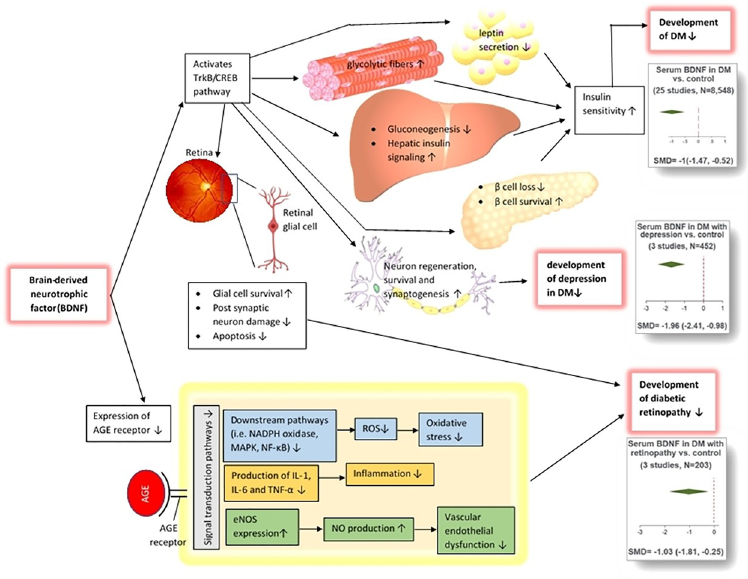
Fig 19. Summary of the pathophysiology and meta-analysis of the association between BDNF and DM. The image of the retina was copyright free and taken from the following link: https://www.kindpng.com/imgv/ThRohi_eye- structure-without-label-hd-png-download/. The image of the liver was copyright free and taken from the following link: https://commons.wikimedia.org/wiki/File:201405_liver.svg. The image of the skeletal muscle was adopted from the following link upon permission: https://www.123rf.com/photo_17709304_types-of-muscle-tissue-skeletal-muscle- smooth-muscle-cardiac-muscle-vector-scheme.html?vti=mpyziptnbswfclfagp-5-19. The image of the pancreas was copyright free and taken from the following link: https://app.biorender.com/illustrations/edit/ 60b24afd8878ed00a4f9c851. The image of the pancreas was copyright free and taken from the following link: https:// togotv.dbcls.jp/en/togopic.2014.21.html. The image of the neuron was copyright free and taken from the following link: https://p.kindpng.com/picc/s/581-5810486_derived-neuron-schema-with-no-labels-neuron-psychology.png. BDNF: Brain-derived neurotrophic factor; DM: Diabetes mellitus; ROS: Reactive oxygen species; AGE: Advanced glycation endproducts; Trkb/CREB: Tyrosine kinase B/cAMP-response element binding protein; eNOS: Endothelial nitric oxide synthase; NO: Nitric oxide; NADPH: Nicotinamide adenine dinucleotide phosphate; MAPK: Mitogen- activated protein kinase; IL: Interleukin; TNF: Tumor necrosis factor.